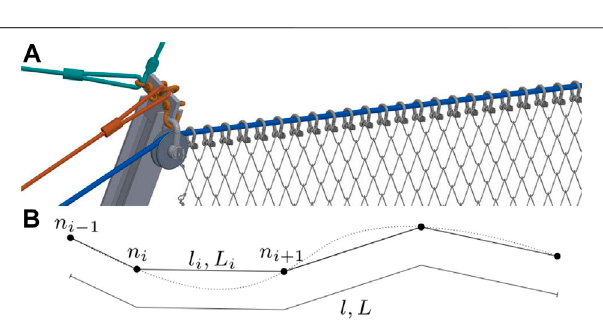
FIGURE 3 | Upper support rope. (A) Installation taken from Geobrugg (2019). (B) Sliding cable element, FEM discretization.